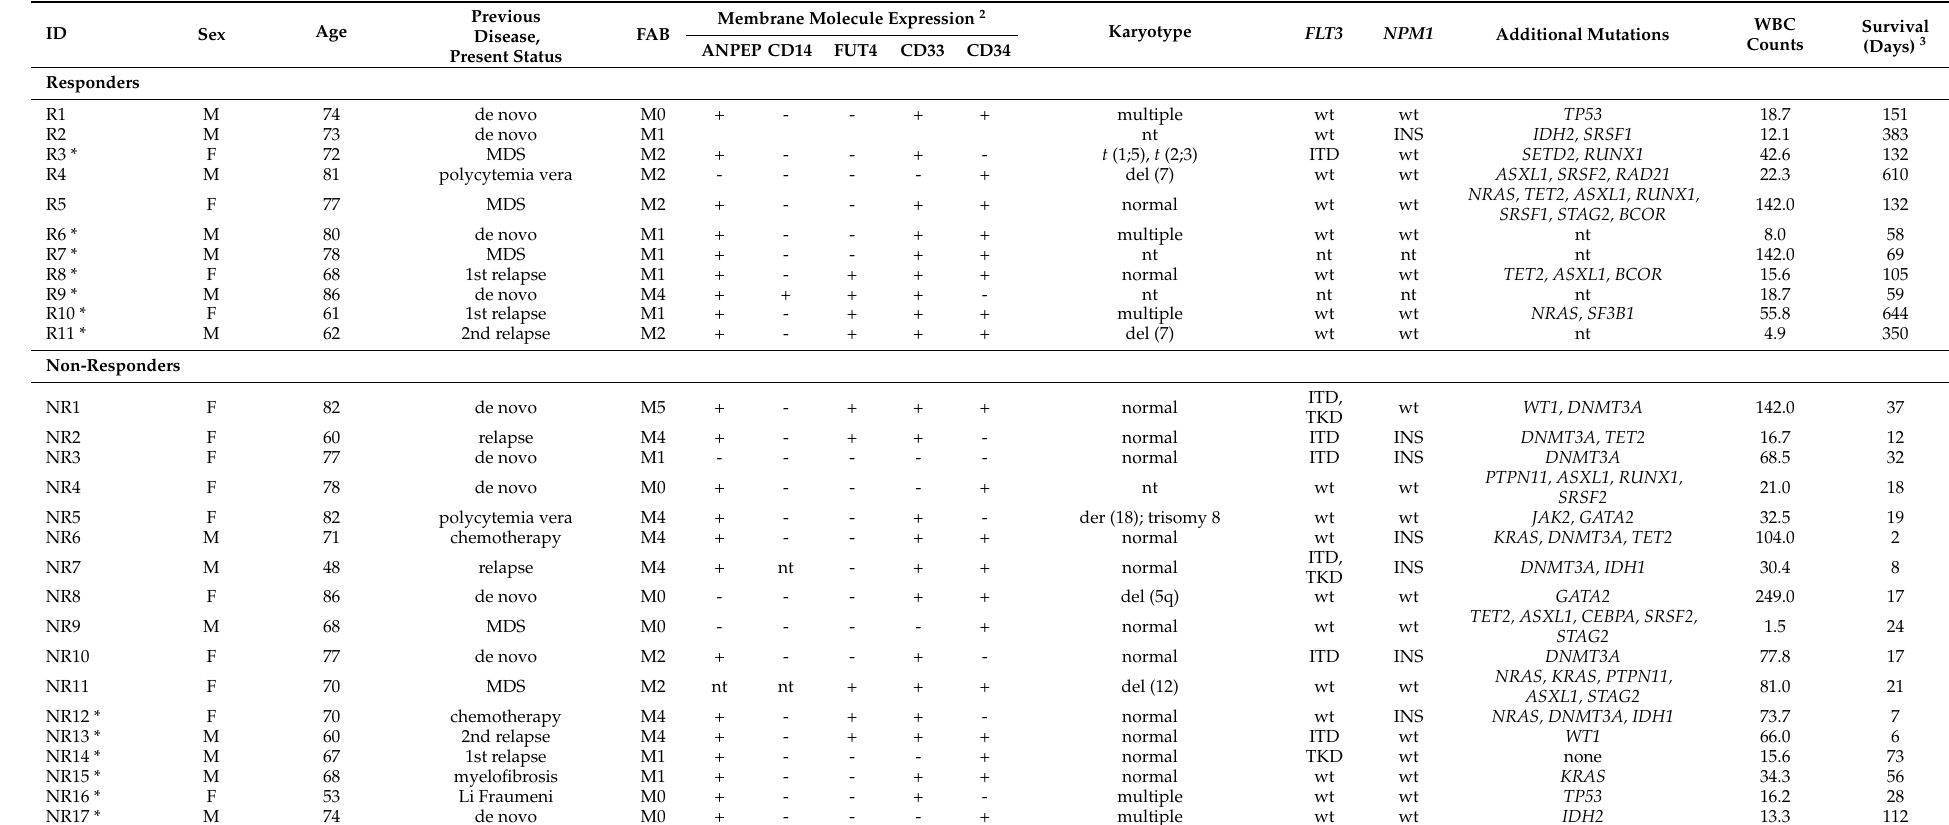
Table 1. Clinical and biological characteristics of the included patients 1